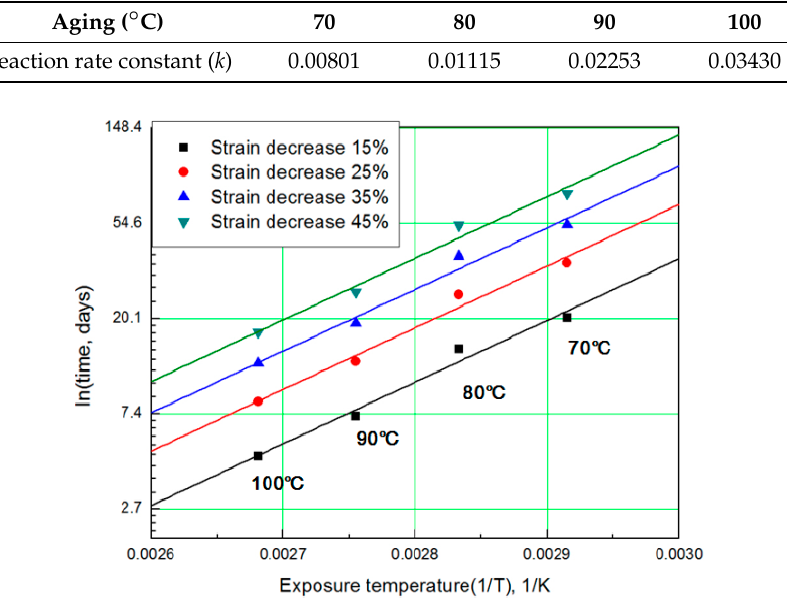
Figure 7. General Arrhenius plot according to the characteristic value.